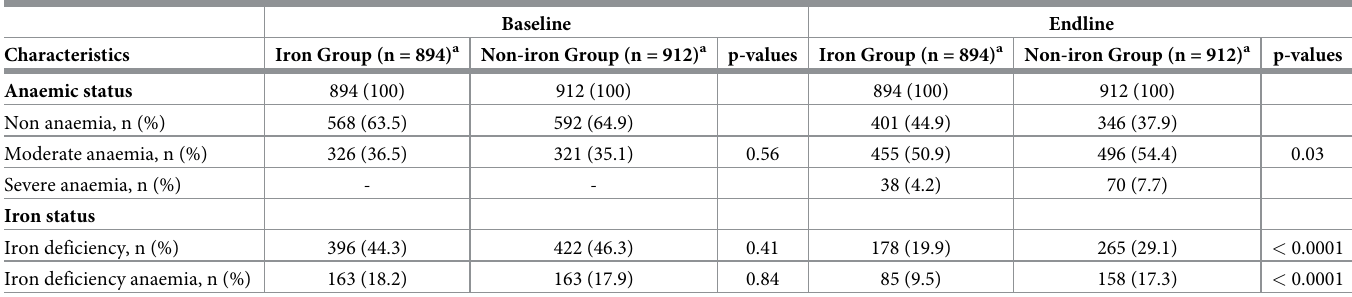
Baseline Endline